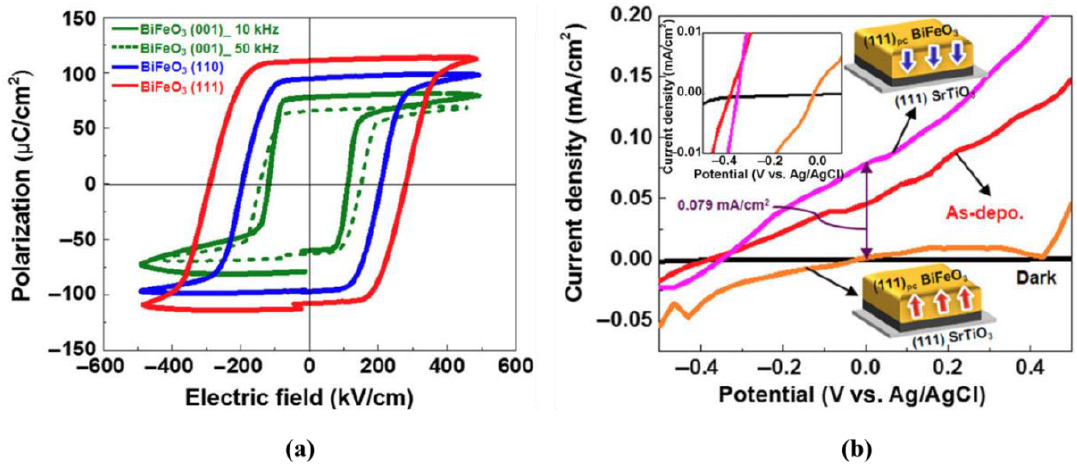
Figure 10. ( a ) P–E hysteresis loop for a 400-nm-thick epitaxial BiFeO 3 thin film with (001) pc BFO at 10 kHz and 50 kHz frequencies and (110) pc , (111) pc BFO thin film at 10 kHz. ( b ) Polarization switching measurement of the 50-nm thick (111) pc BFO thin film photoanodes in different polarization states. The inset shows the magnified portion for the onset potential [4]. Copyright 2018, Springer.